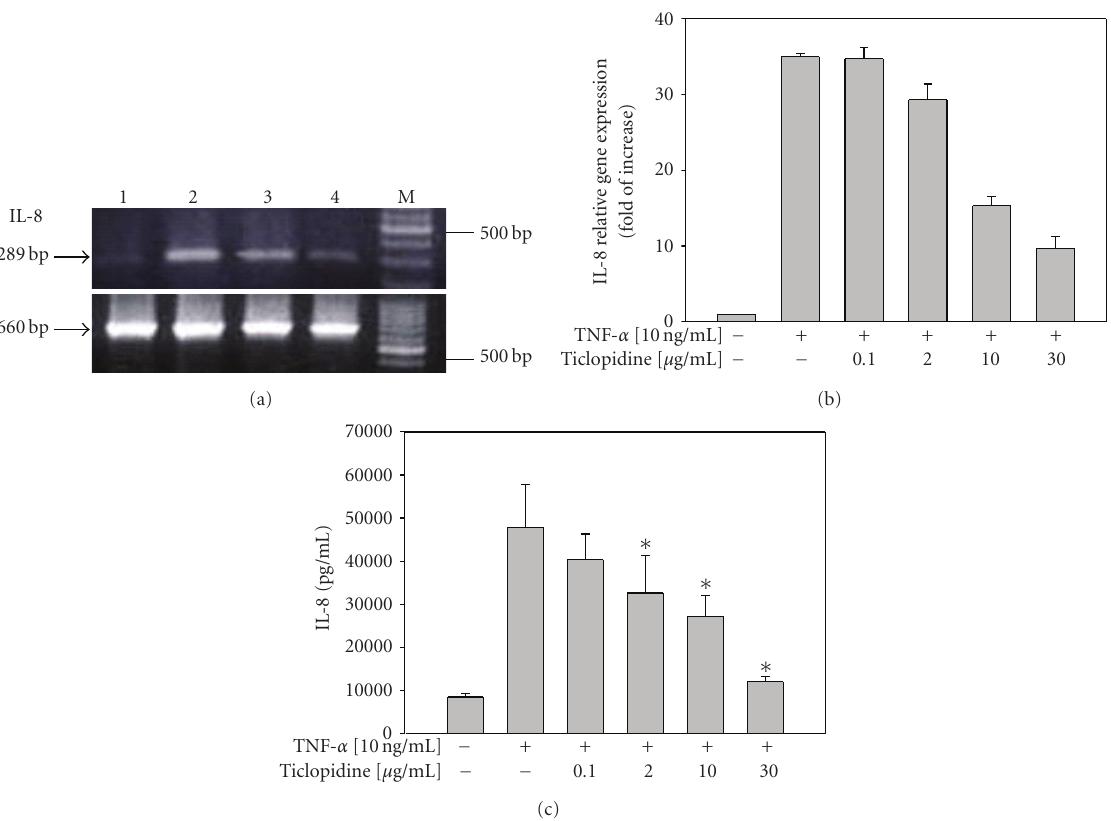
Figure 2: Reduction of IL-8 mRNA and protein levels by ticlopidine in HUVECs. HUVECs were incubated with serum-free medium for 12hours before di ff erent concentrations of ticlopidine were added, after 12 hours incubation cells were stimulated with/without TNF- α (10ng/mL) for another 24hours. (a) Total RNA was extracted and analyzed by RT-PCR. Lane 1, without TNF- α ; lane 2, TNF- α (10ng/mL) alone; lane 3, TNF- α + ticlopidine (0.1 μ g/mL); lane 4 TNF- α + ticlopidine (30 μ g/mL); M denotes molecular size marker. The lower panel is β -actin as the internal control. Results are representative one of three independent experiments. (b) Relative amount of IL-8 mRNA level was determined by quantitative real-time RT-PCR. (c) Culture supernatants were analyzed by ELISA. Data are expressed as the mean ± SEM of duplicate wells and are representative of six individual experiments. Significantly di ff erent versus TNF-treated alone ∗ P < .05, ∗∗ P <